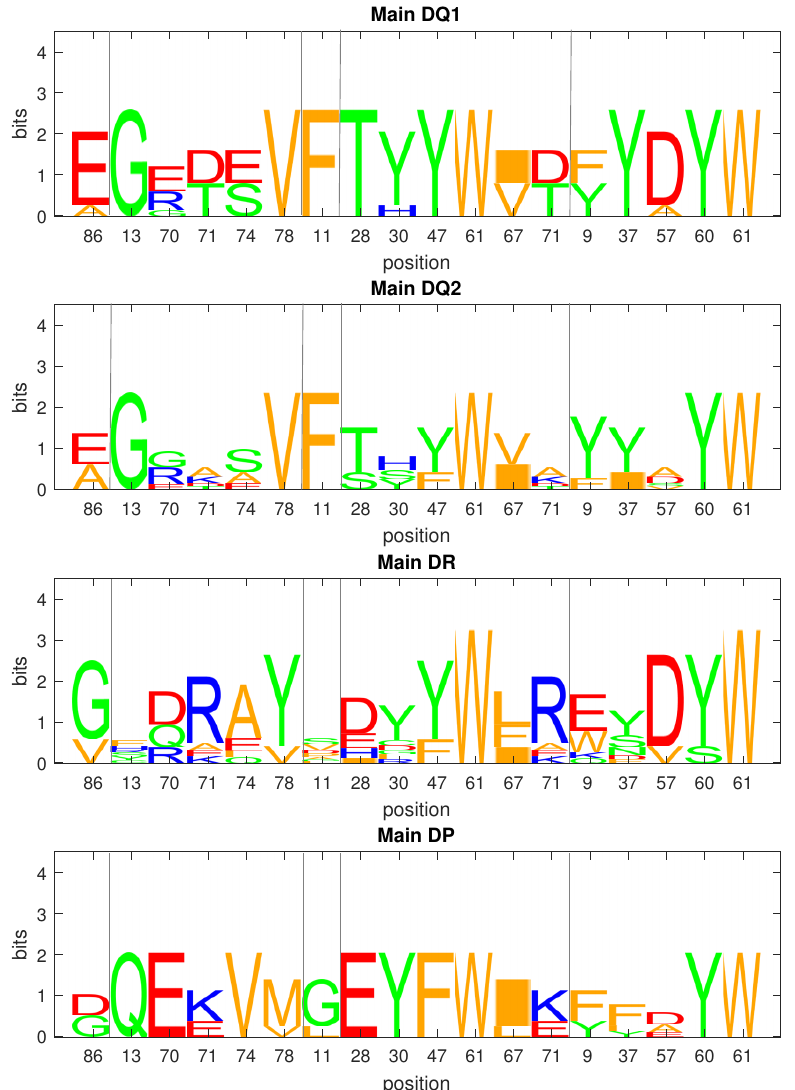
Figure 3. Sequence logos for anchor pocket residues of MHC II β chains. The residues making up anchor pockets 1, 4, 6, 7, and 9 are separated by gray vertical lines. Pocket 1 consists of residue 86. Pocket 4 consists of residues 13, 70, 71, 74, and 78. Pocket 6 consists of residue 11. Pocket 7 consists of residues 28, 30, 47, 61, 67, and 71. Pocket 9 consists of residues 9, 37, 57, 60, and 61. The residues are numbered based on the HLA-DR β